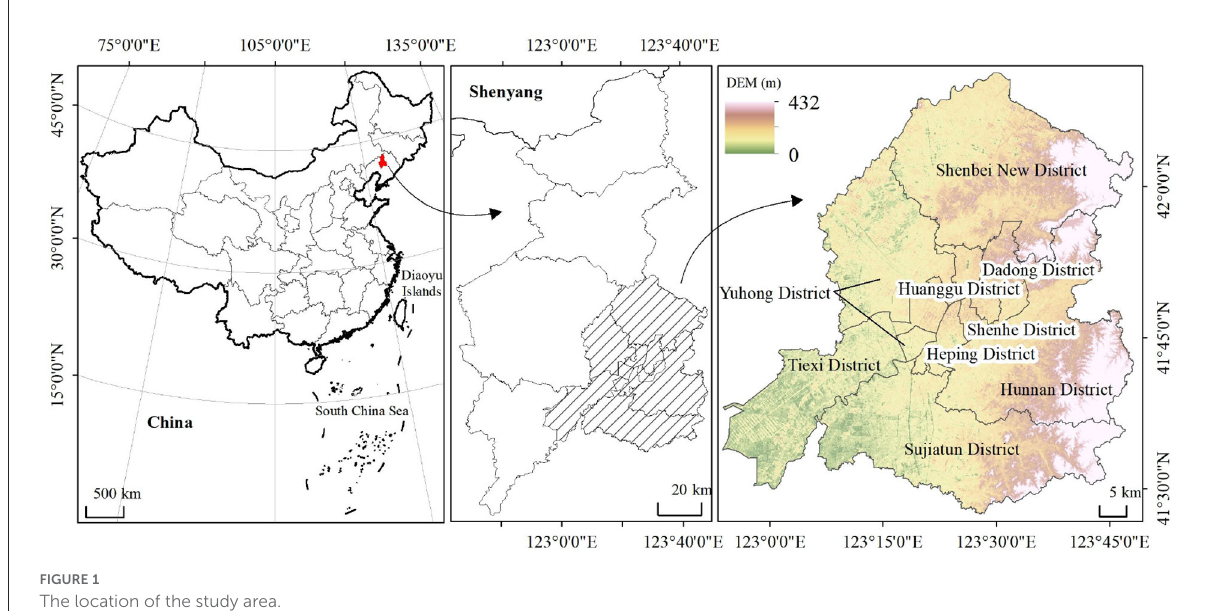
FIGURE1 The location of the study